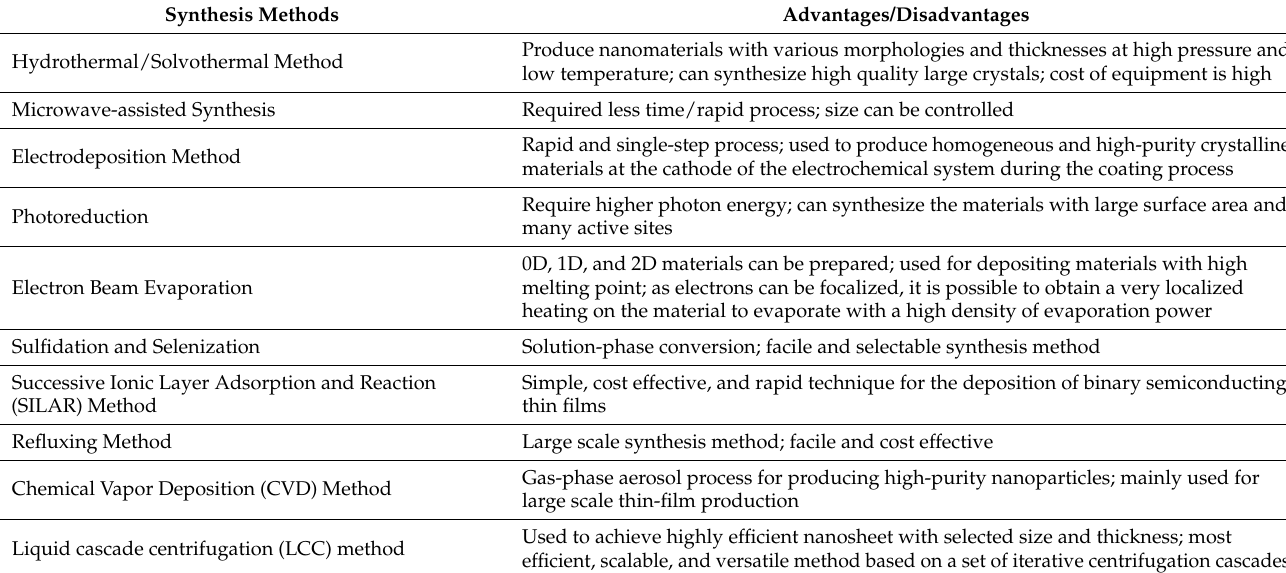
Table 1. Summary of the different types of the synthesis method of